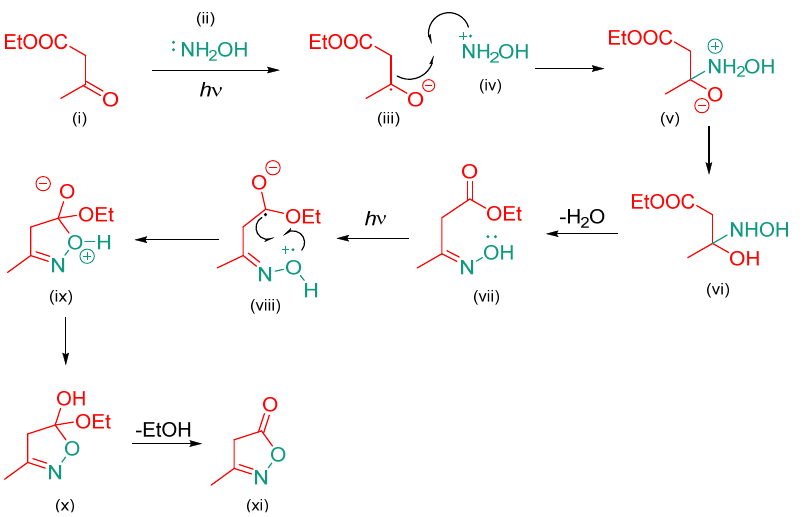
Scheme 3. Proposed mechanism for the photochemical synthesis of the isoxazolone